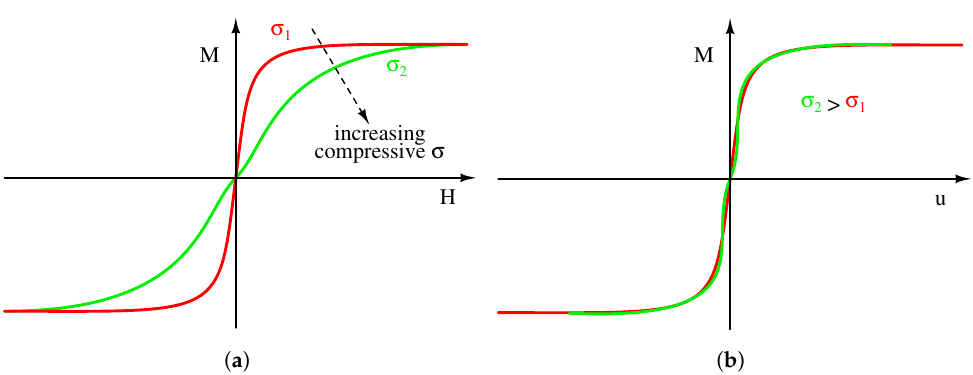
Figure 3. ( a ) Illustration representing a typical qualitative magnetic characteristic (hysteresis is neglected): M is the magnetization, H is the magnetic field, and σ is the mechanical stress. The com- pressive applied stress is assumed to be negative, particularly | σ 2 | > | σ 1 | ; ( b ) graphical view of the self-similarity property of a magnetostrictive material, where u is the self-similar variable defined as reported in Equation